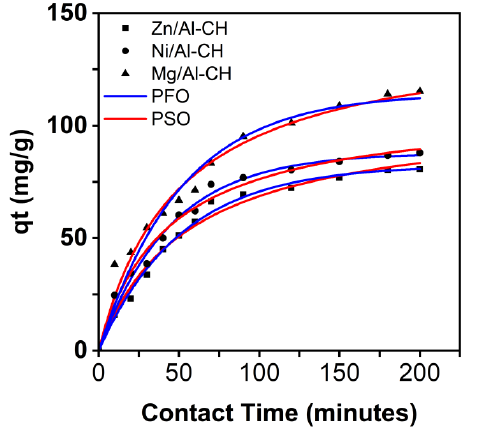
Figure 7. Effect of adsorption time on Zn/Al-CH (a), Ni/Al-CH (b),